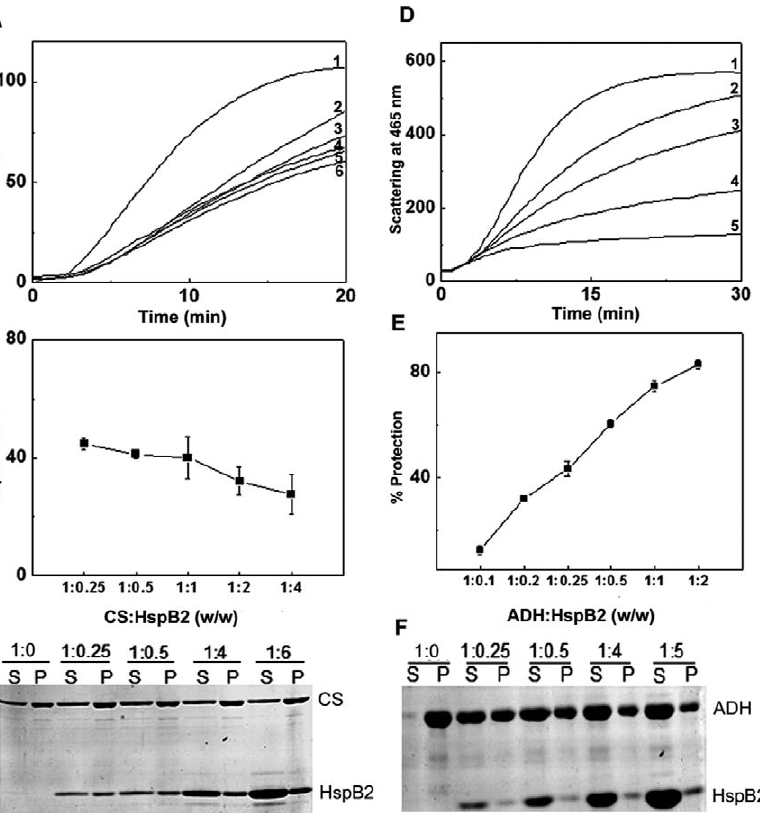
Figure 8. Effect of HspB2 on the thermal aggregation of citrate synthase (CS) at 43 6 C. (a) Aggregation profile of 25 m g/ml CS alone (1) and in the presence of 1:4, (2); 1:2, (3); 1:1, (4) 1:0.5, (5) and 1:0.25, (6) ratios of CS to HspB2 (w/w). (b) The apparent percentage protection calculated from light scattering profile as a function of the weight ratio of CS to HspB2. (c) The SDS-PAGE pattern of soluble (S) and precipitate (P) fractions of mixtures of various citrate synthase to HspB2 ratios used in the chaperone assays. The soluble fraction and the precipitate were obtained by centrifugation at the end of the chaperone assay. (d) Effect of HspB2 on the thermal aggregation of yeast alcohol dehydrogenase (ADH) at 48 u C. Aggregation profile of 0.2 mg/ml ADH alone (1) and in the presence of 1:0.1, (2); 1:0.2 (3); 1:0.5, (4); 1:2 (5); ratios of alcohol dehydrogenase to HspB2 (w/w). (e) the percentage protection calculated from light scattering profile as a function of the weight ratio of ADH to HspB2. (f) SDS-PAGE pattern of soluble (S) and precipitate (P) fractions of mixtures of various ADH to HspB2 ratios used in the chaperone assays. The soluble fraction and the precipitate were obtained by centrifugation at the end of the chaperone assay.